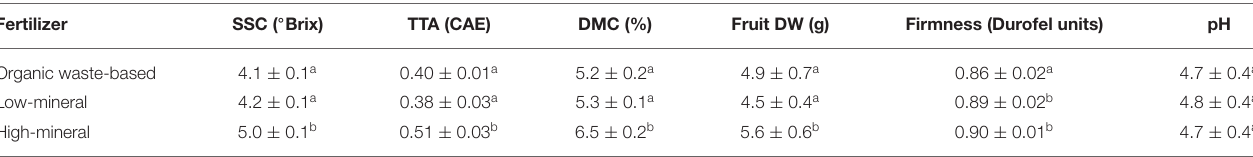
TABLE 4 | Average dry matter content, soluble solids content, total titratable acidity measured in fruits from plants grown under different nutrient conditions, n = 9. Fertilizer